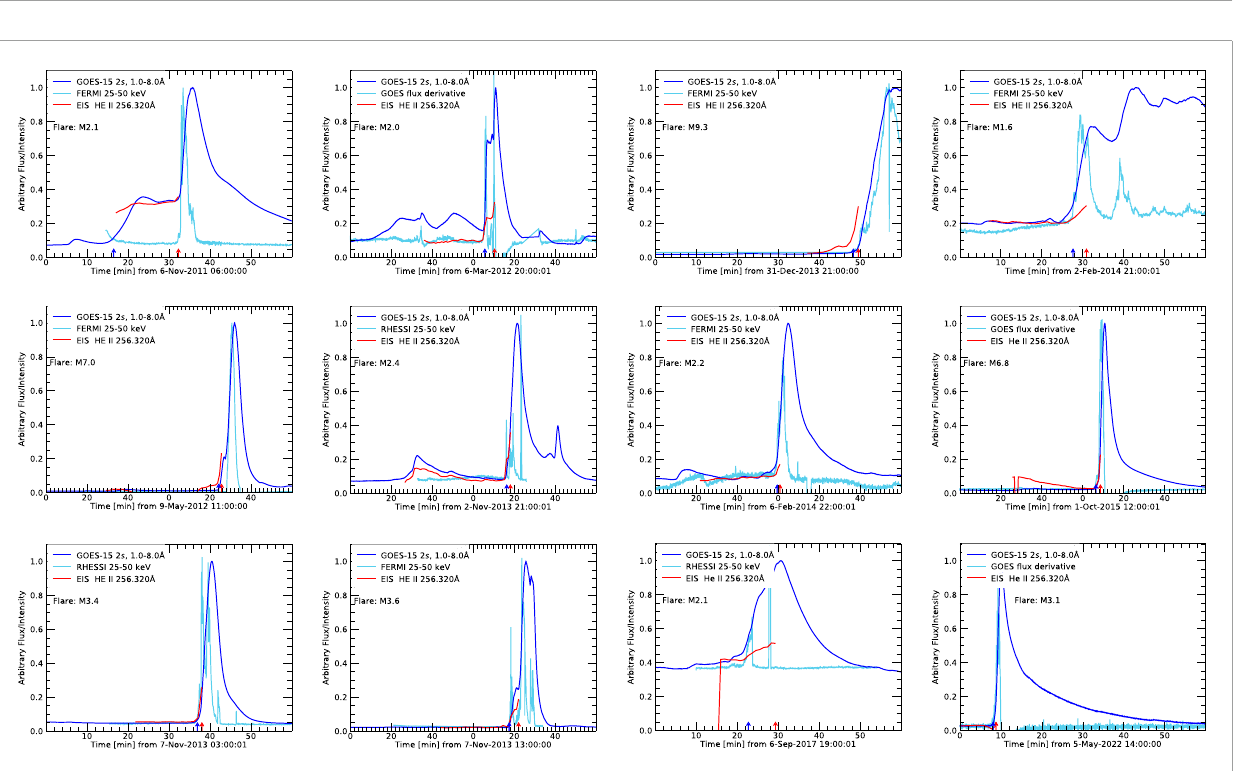
FIGURE 3 Same as the bottom row of Figure 1 for the other flares in our sample. The X-axis labels give the time in minutes from the start time shown in the axis title. The change to 0 in some of the plots indicates 1